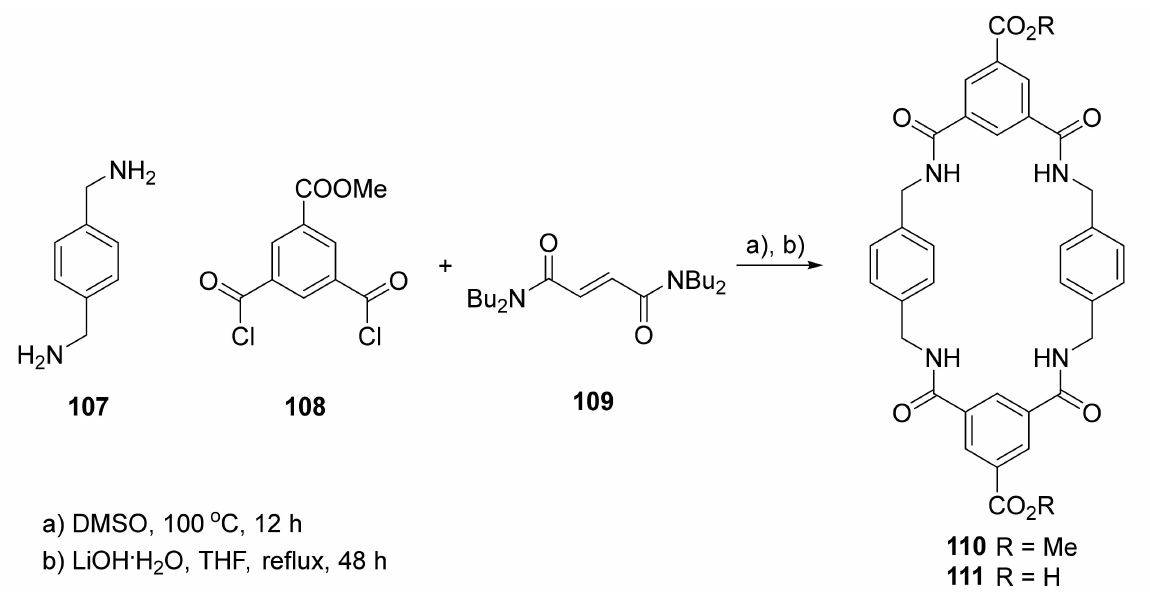
Figure 20. Synthesis of polyamide macrocycle 111 as a starting material for Co- or Zn-based